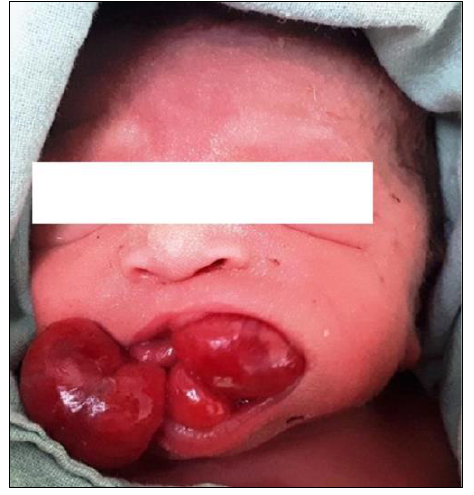
Figure 1: Multiple congenital epulis lesions.